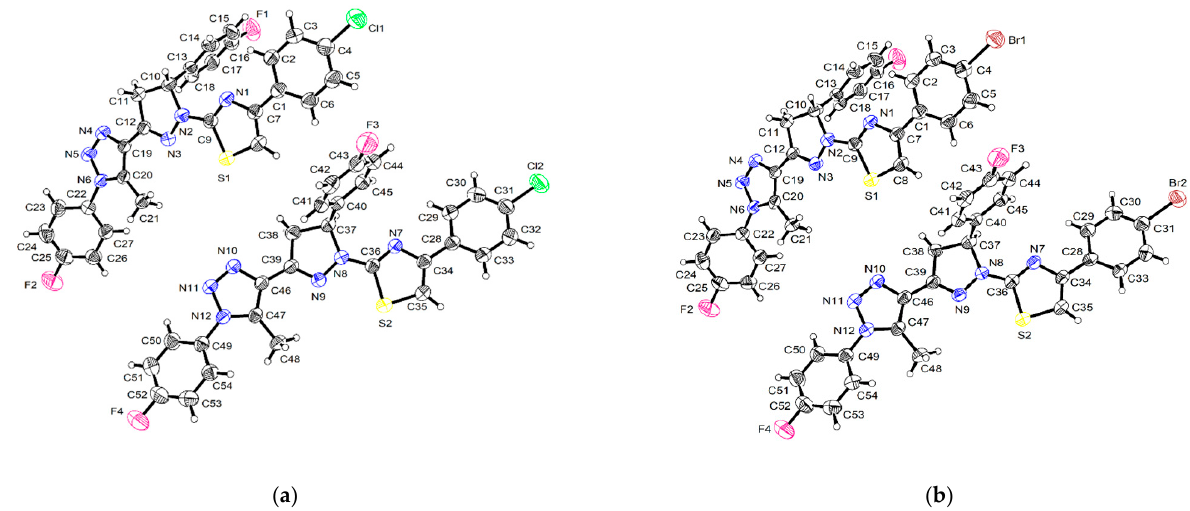
Crystals 2021 , 11 , x FOR PEER REVIEW